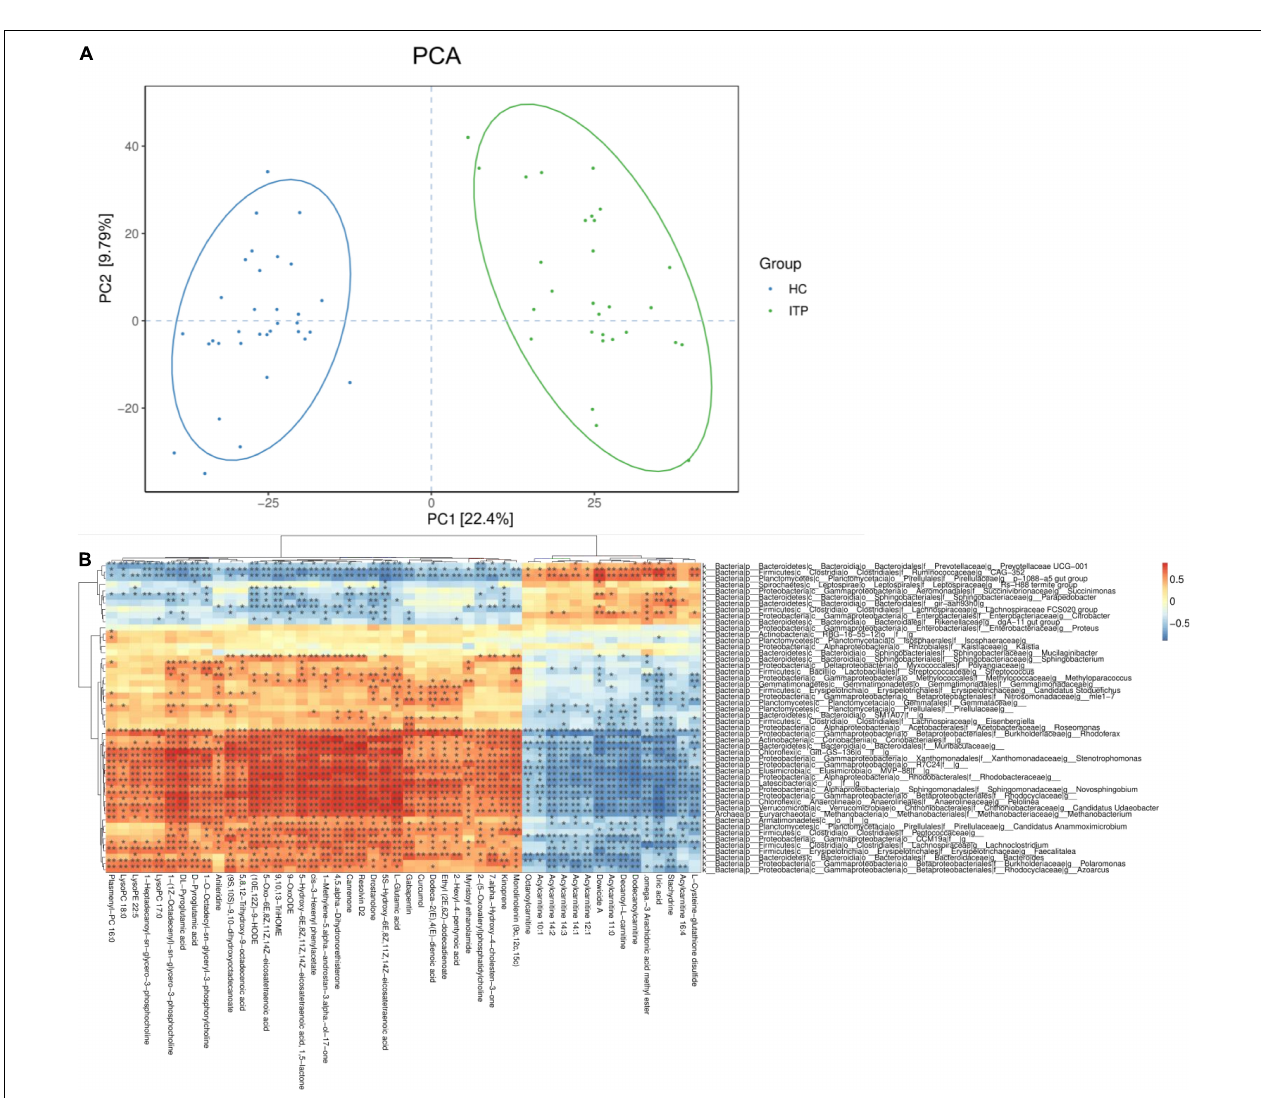
FIGURE 5 | Relationship between serum metabolites and gut microbiota in ITP. (A) The PCA of ITP patients and healthy controls. (B) Heatmap of gut microbiota and metabolites. This heatmap shows a data matrix, where colored areas provided an overview of numeric differences.